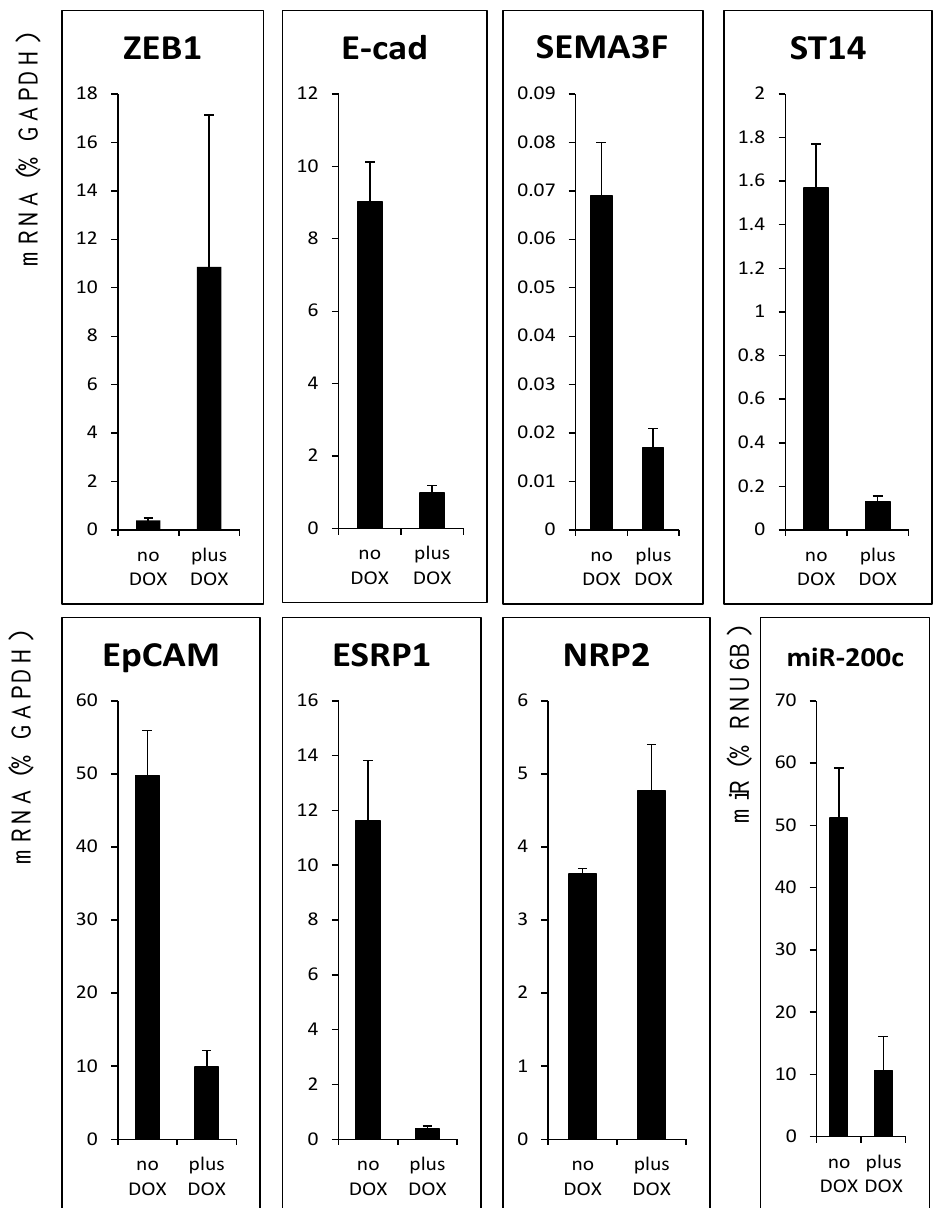
Figure 2. Expression of ZEB1 target gene is decreased in H358 FlipIn ZEB1 cells after 48 h of DOX treatment. mRNA expression was measured by quantitative real-time PCR and values are expressed as percent of GAPDH. For miR-200c, values are expressed as % of RNU6B. Values are the mean from three independent experiments with qRT-PCR in duplicate. Bars =